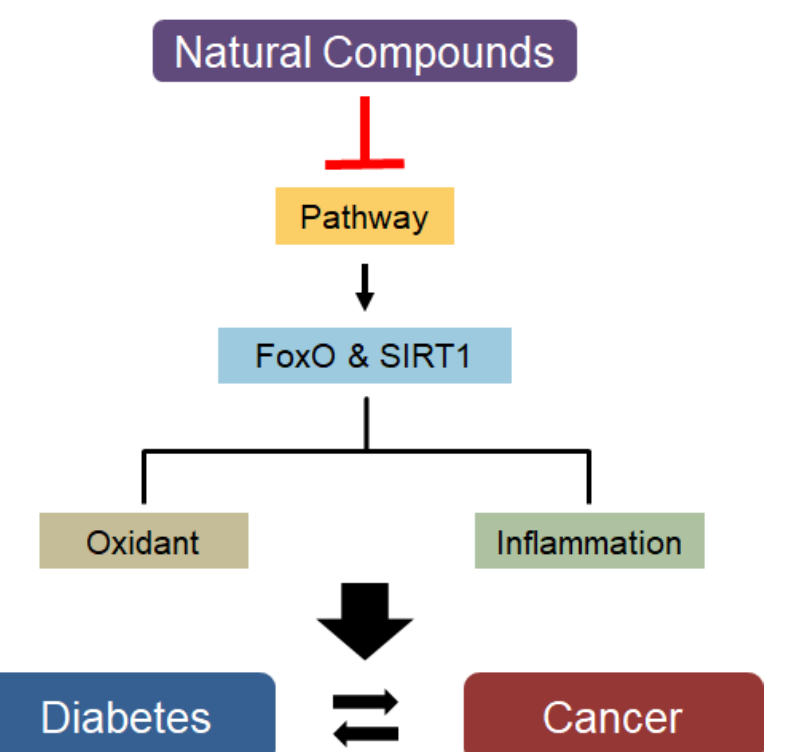
Figure 2. Functions of FoxO and SIRT1 targeted genes and their modifications by natural compounds and their involvements during diabetes and cancer.